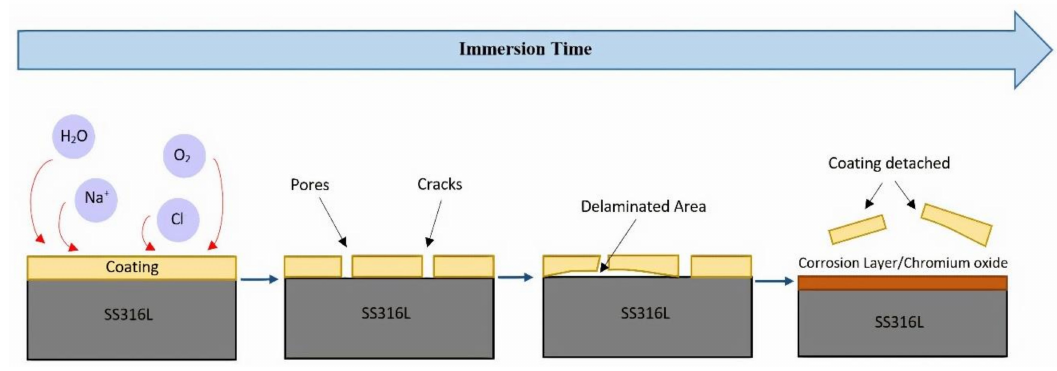
Figure 1. The degradation process of